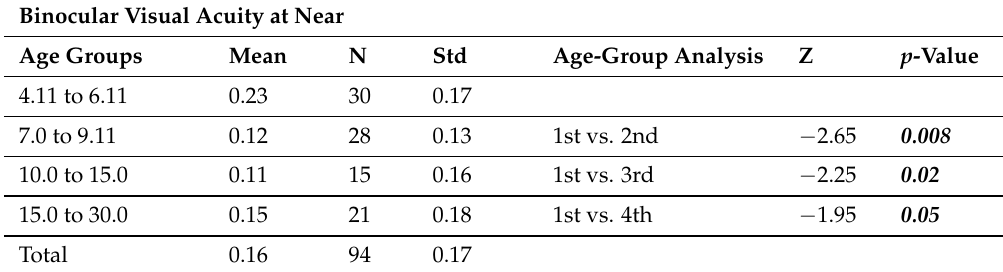
Table 3. The relationship between age groups and the amount of visual acuity at near for PS patients with stereopsis (N = 94).